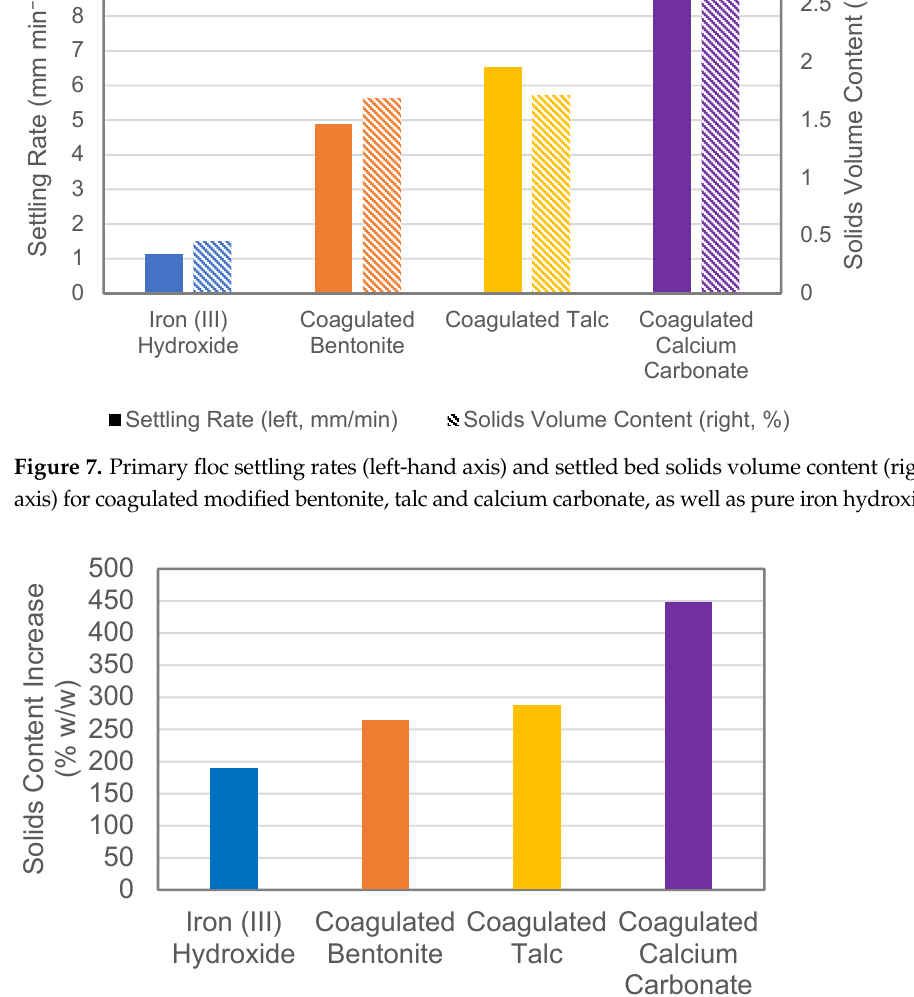
Figure 7. Primary floc settling rates (left-hand axis) and settled bed solids volume content (right- hand axis) for coagulated modified bentonite, talc and calcium carbonate, as well as pure iron hy- droxide flocs.